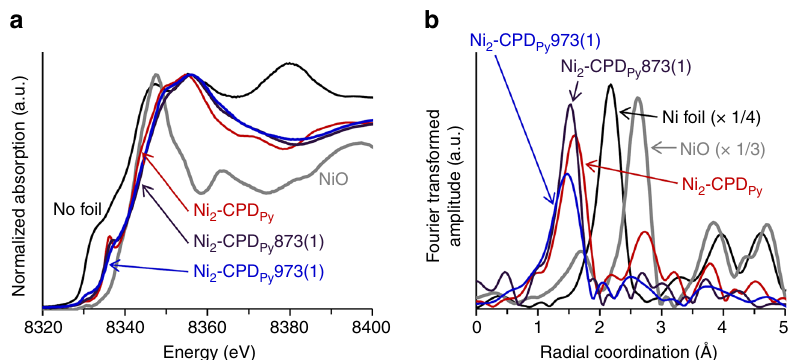
Fig. 5 X-ray absorption fi ne structure results of Ni 2 -CPD Py and its heat-treated samples. a XANES spectra. b Pseudo-radial structural functions calculated from EXAFS patterns. The data of Ni foil and NiO are also shown for